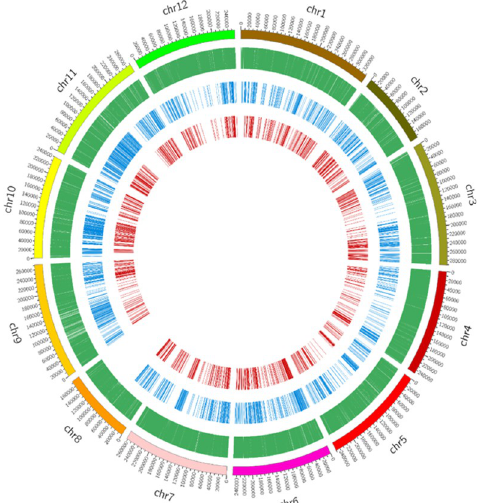
Fig 2. Genome-wide distribution of SNPs and bins across pepper genomes. The outermost box with scale represents the 12 pepper chromosomes. The green histogram represents the density of raw SNPs; the blue histogram indicates the SNPs that are polymorphic between LP97 and ECW30R that were used for bin construction; the red histogram indicates the bins of adjacent SNPs that were used for linkage-map